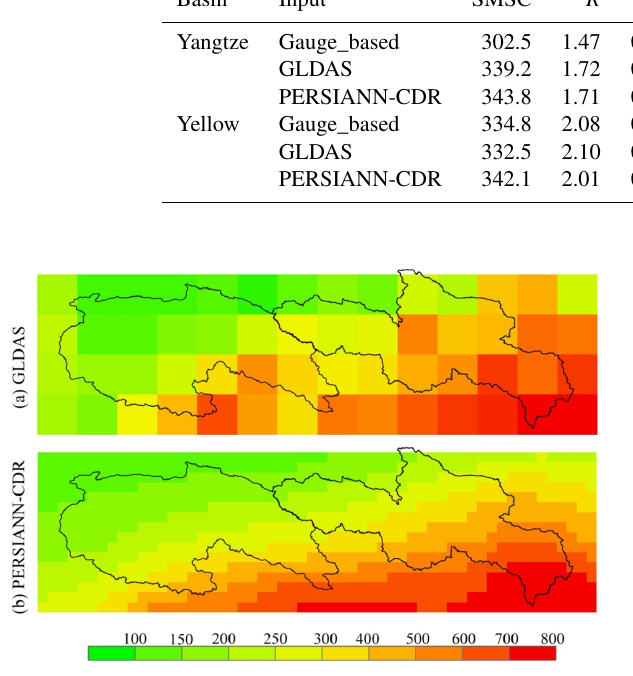
Figure 3. The spatial distribution of average annual values of 1.0 ◦ resolution GLDAS precipitation (a) and 0.25 ◦ resolution PERSIANN-CDR precipitation (b)